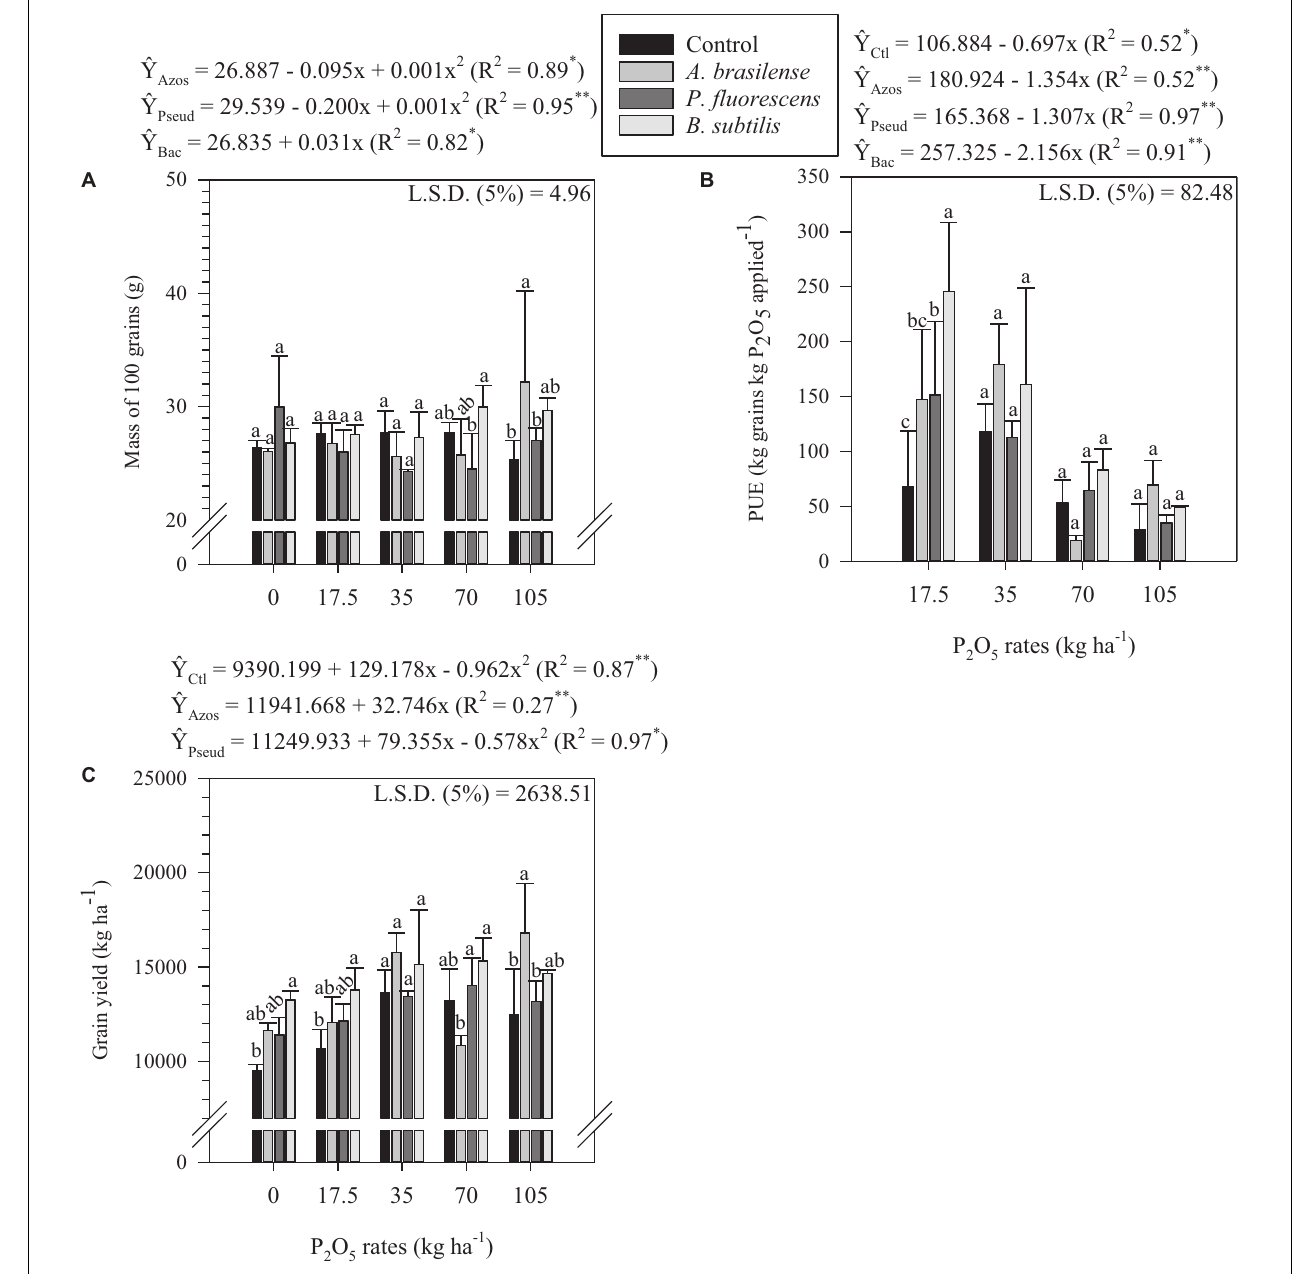
FIGURE 4 | Mass of 100 grains (A) , PUE (B) , and grain yield (C) as a function of the interaction between P 2 O 5 rates and inoculations in corn crop. The letters correspond to a significant difference at 5% probability level ( p ≤ 0.05). Error bars indicate the standard deviation of the mean ( n = 4). Ctl, Azos, Pseud e Bac refers to the control treatment and inoculations with A. brasilense , P. fluorescens and B. subtilis , respectively. L.S.D. (least significant difference), PUE (P use